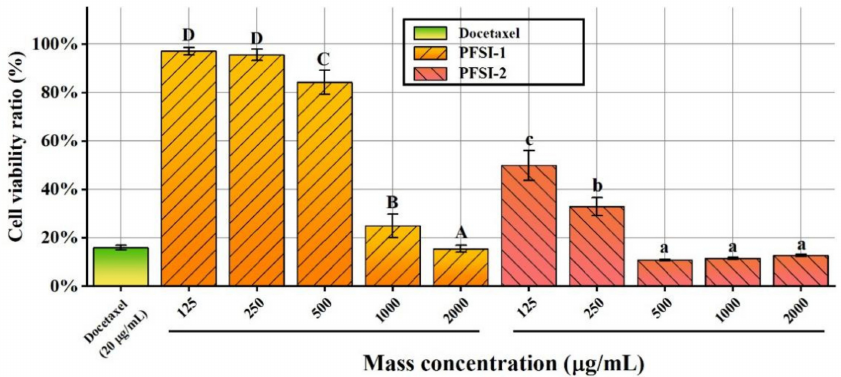
Figure 8. Effect of PFSI-1 and PFSI-2 on the viability of SMMC 7721 cells. (Note: the same small (capital) letters indicate no significant difference between groups, and different small (capital) letters indicate a significant difference between groups, p <